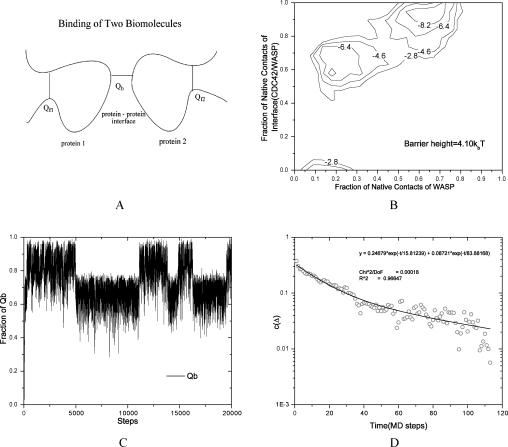
Illustration of Flexible Binding-Folding through Two-Dimensional Free-Energy Landscape, Trajectory and Time Correlation(A) Flexible binding-folding.(B) Two-dimensional free-energy contour plots of the interface degree of freedom between CBD portion of WASP and Cdc42, and conformation/folding degree of freedom for CBD.(C) Typical trajectory of fraction of native contacts of binding interface between CBD portion of WASP and Cdc42.(D) Time correlation function of fraction of native interface contacts.